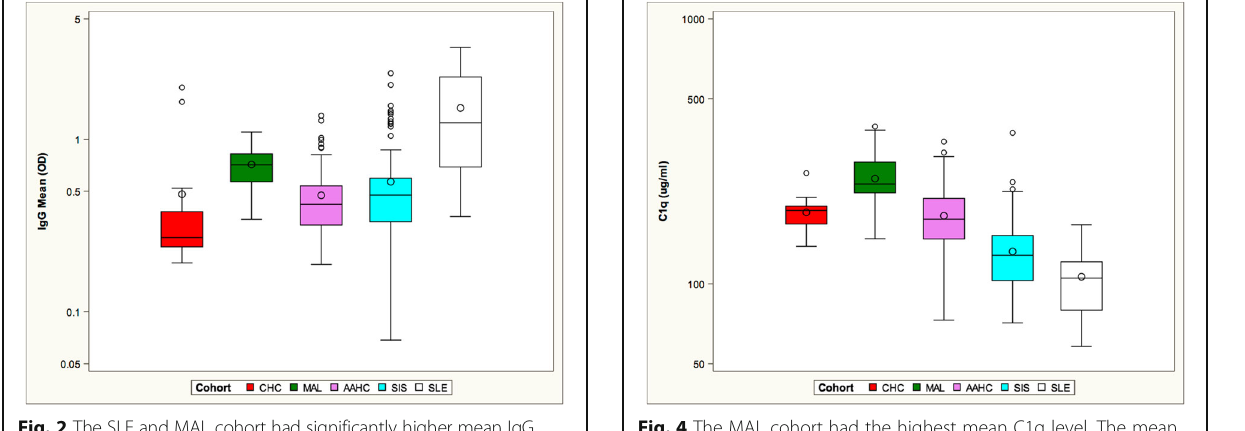
Fig. 4 The MAL cohort had the highest mean C1q level. The mean C1q levels of the CHC and AAHC cohorts did not differ from each other. The SIS cohort had a lower mean C1q level and the SLE cohort had the lowest level